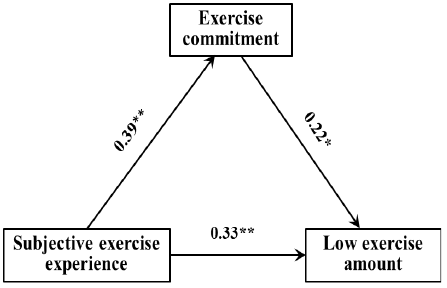
Figure 2. The path model of exercise commitment between subjective exercise experience and low exercise amount. * p < 0.05; ** p < 0.01.